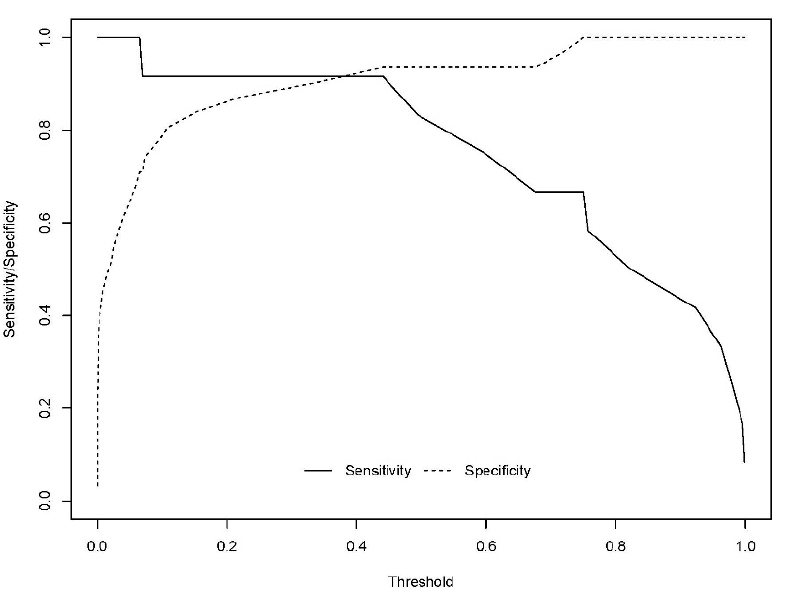
Figure 5. Sensitivity and specificity profile plot. The continuous line represents the relationship between the probability threshold set in the model’s prediction and the sensitivity. The dashed line represents the relationship between the probability threshold and the specificity.